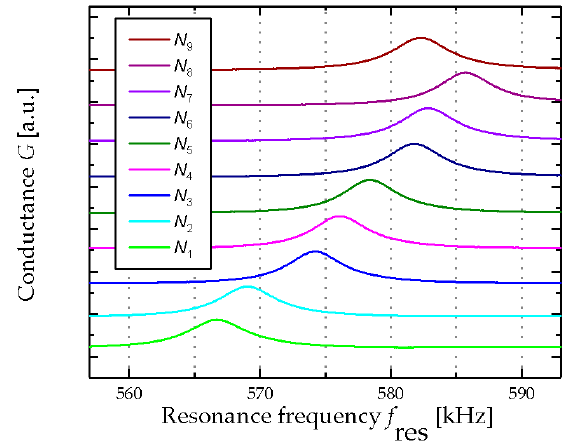
Figure 6. Electrical output characteristics of the piezoelectric MEMS resonator for an ordinary fermentation process N 1 – N 9 , starting with N 1 at the bottom and all other model solutions ( N 2 – N 9 ) stacked above. The y -axis is scaled as arbitrary unit [a.u.].